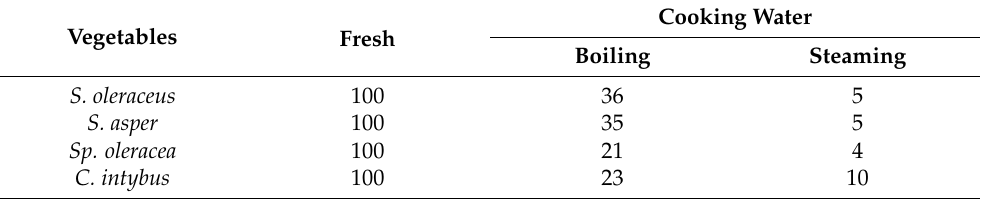
Cooking Water Boiling Steaming